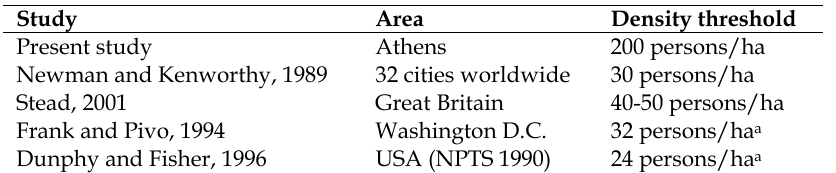
Table 6. Density thresholds in different countries Study Area Density threshold Present